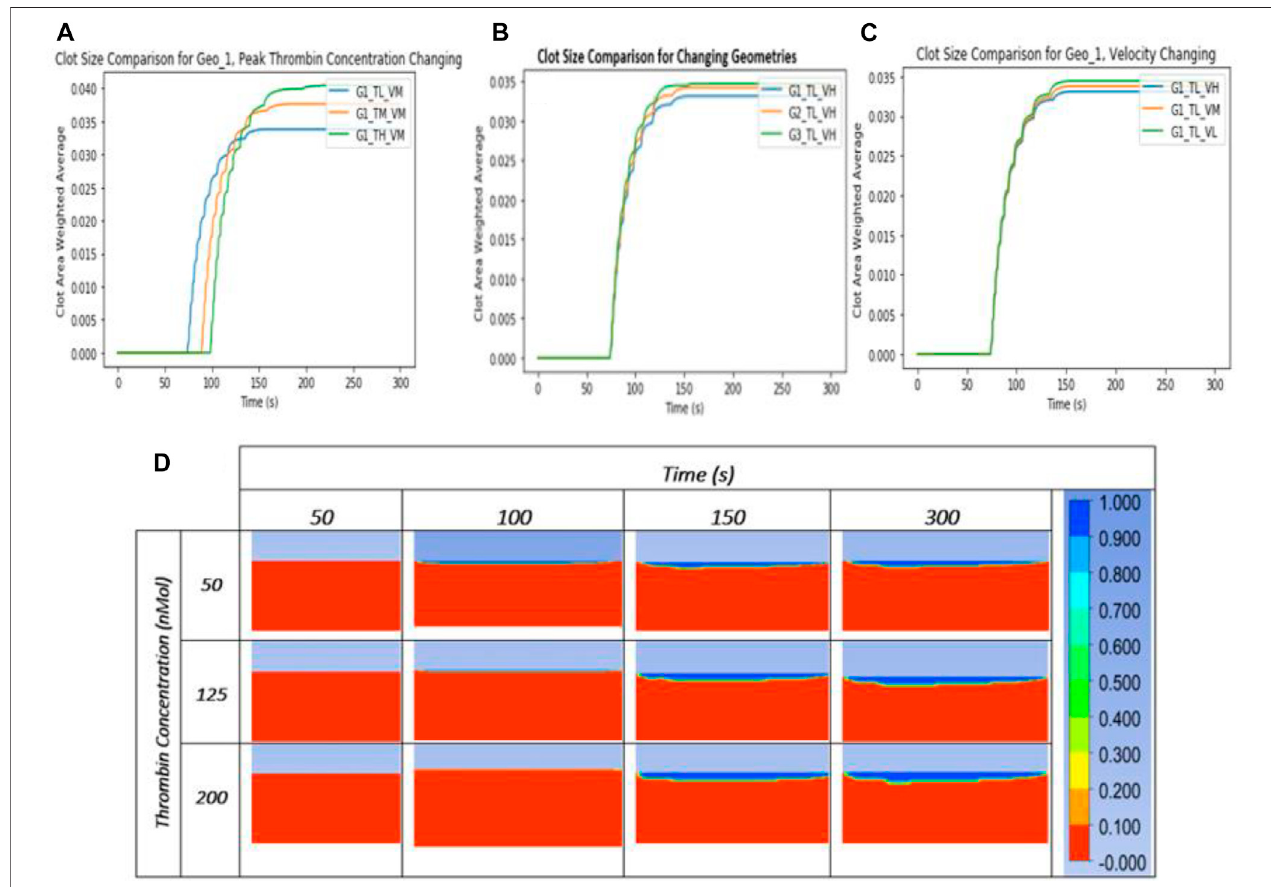
FIGURE 4 | Graphs comparing the size of clot in the two-dimensional model formed for variations of (A) peak thrombin concentration, (B) vein geometry, and (C) bloodvelocityover300s. (D) Clotcontourplotcomparingcaseswithdifferentthrombinconcentrations.Ascalartrackingtheclottedareachangesfromzerotoonewhen the area has fully